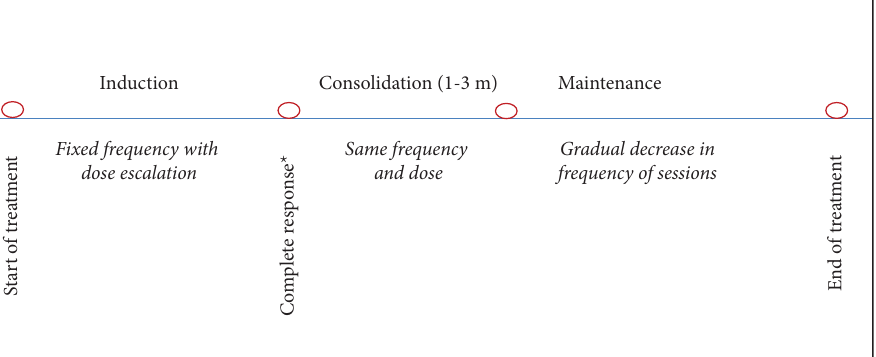
Supplementary Table 1: ISCL/EORTC revision of the TNMB classifcation of MF/SS (2007). Supplementary Table 2: histopathologic staging of lymph nodes in MF/SS (2007).